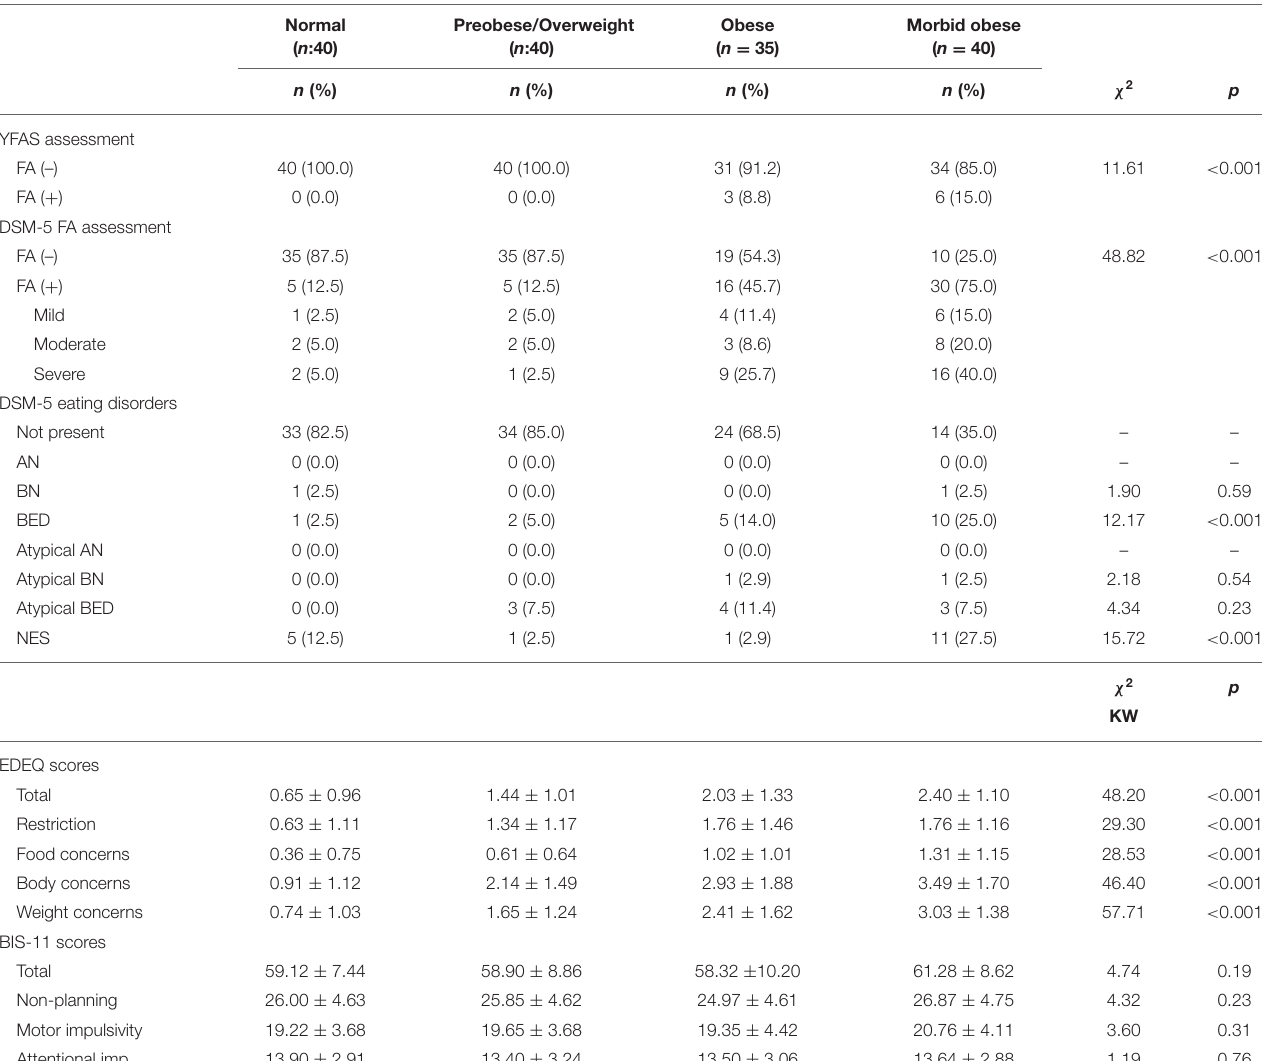
TABLE 3 | Food addiction and eating disorders diagnoses and symptomatology and impulsivity in different BMI groups, as assessed by YFAS and DSM-5 clinical interviews, EDEQ, and BIS-11.